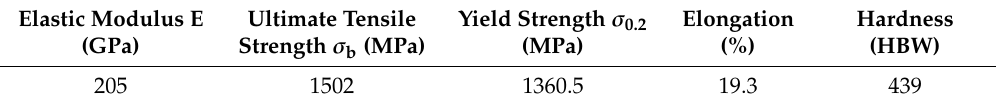
Table 2. Tensile mechanical properties of the material at room temperature